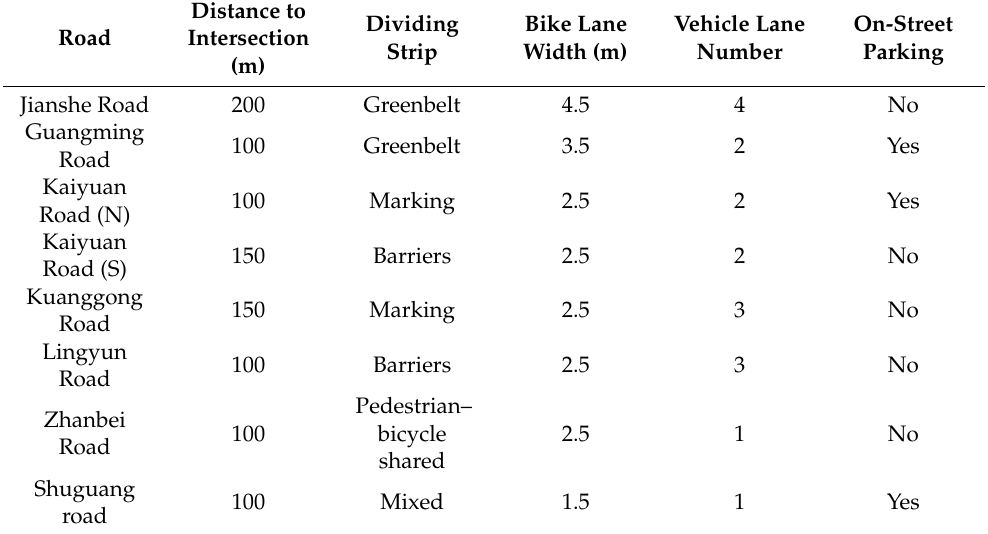
Table 1. Road geometry at field data